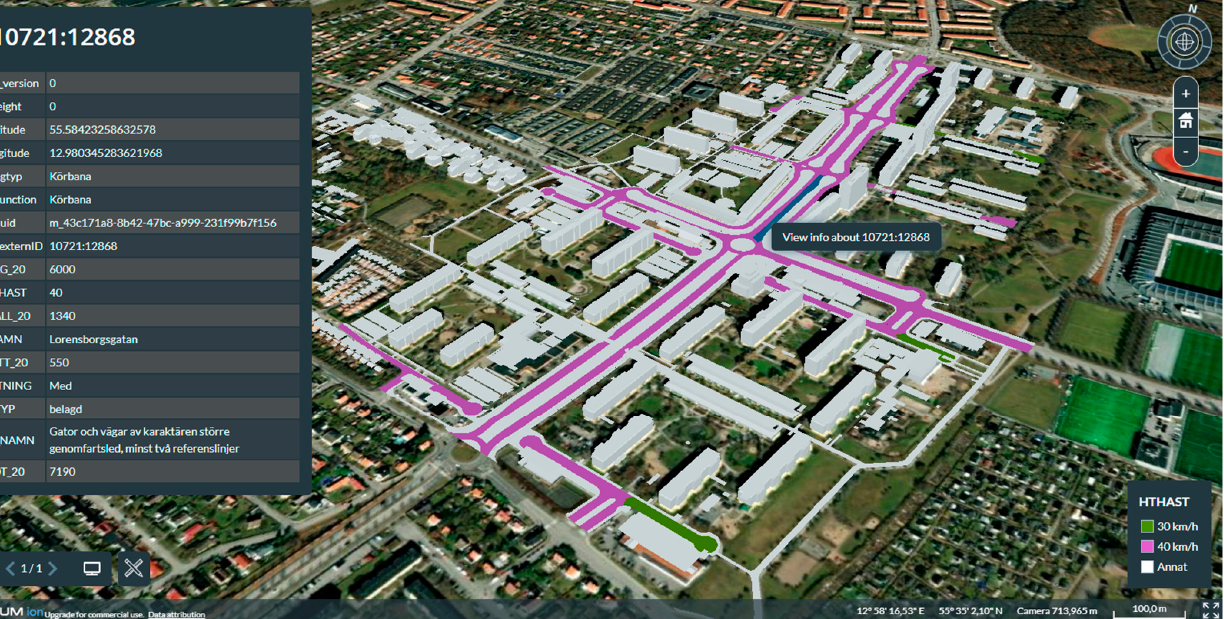
Figure 16. The transportation theme and buildings in Malmö visualised in Cesium. Streets with car traffic are coloured according to the speed limit ( HTHAST ) derived from NVDB. The attributes—some extracted from external road databases (NVDB and municipality)—for one selected traffic area ( road link id = 10,721:12,868 ) are shown in the upper left part.